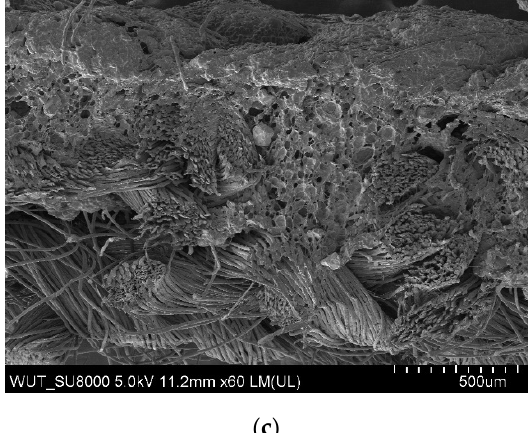
Figure 5. ( a ) SEM image of coating incorporating SiC with a particle size of 100–450 µm (additive 5). ( b ) SEM image of coating incorporating SiC with a particle size of 50–450 µm (additive 6). ( c ) SEM image of coating incorporating SiC with a particle size of 53–75 µm (additive 7).